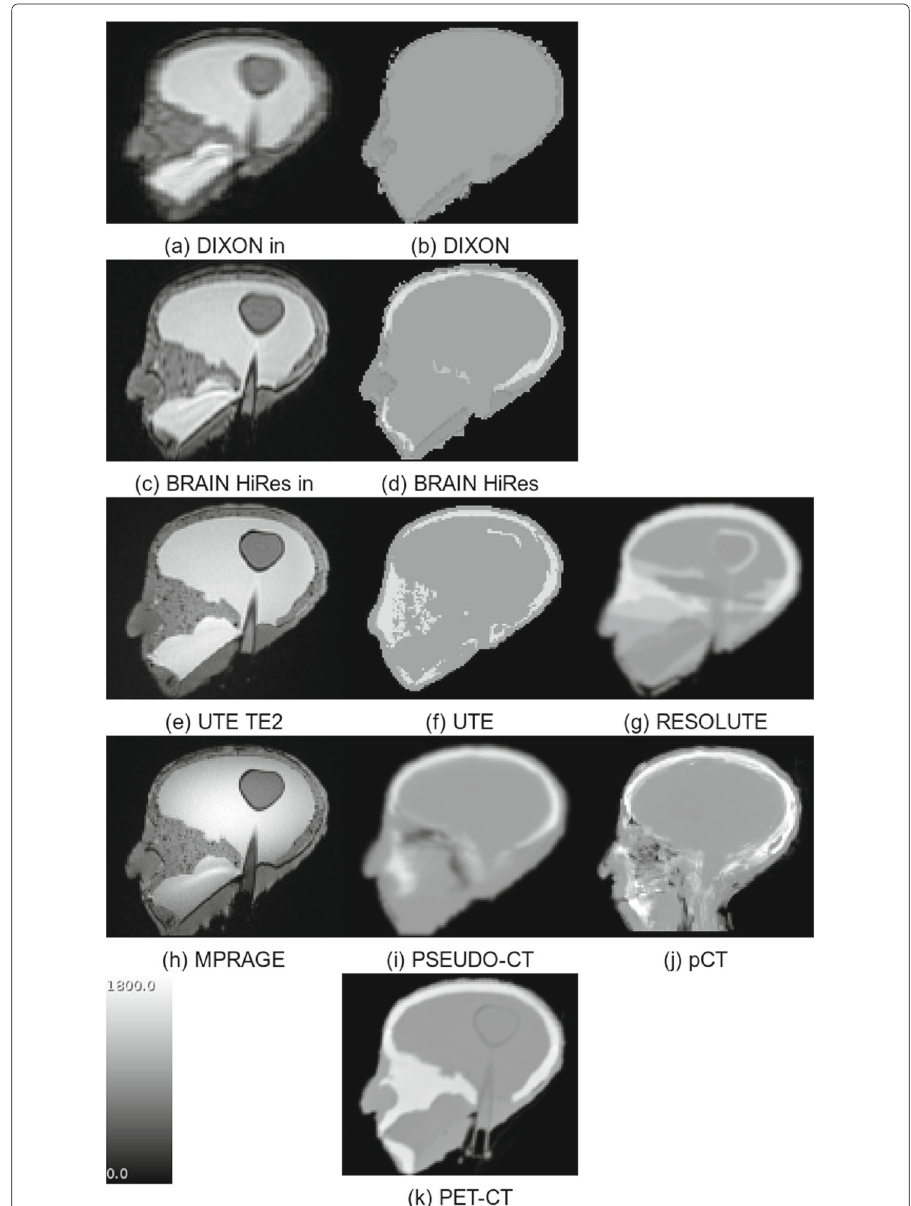
Fig. 2 MRI data (leftmost column) and μ -maps derived from it (other columns). a , c The magnitude of the in-phase Dixon data and e the second echo of the UTE sequence. The μ -maps are labeled the same as in Table 1. For comparison, k displays the μ -map derived from the CT data of the PET-CT examination